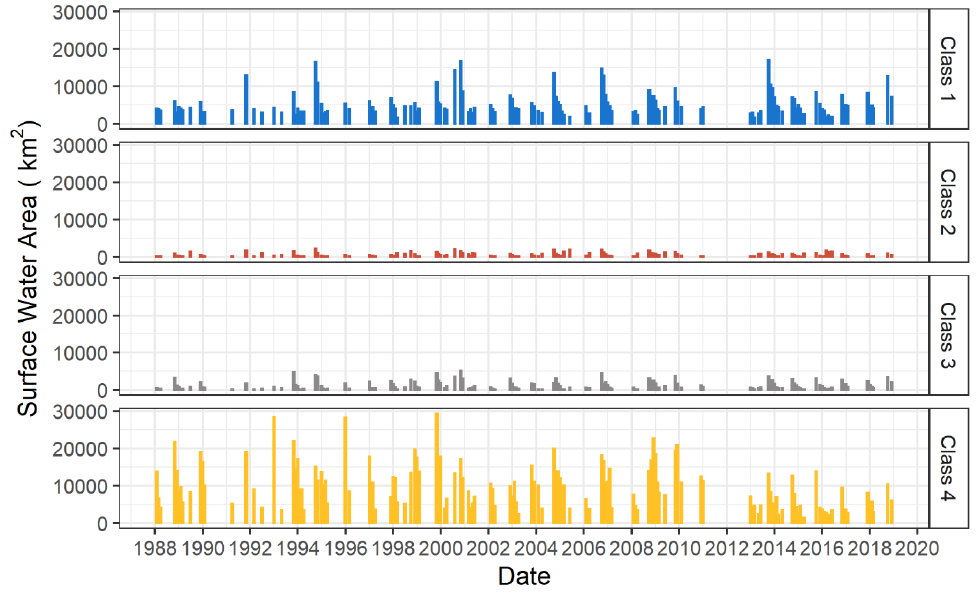
Figure 4. Surface water area by DSWE water class for Cambodia, plotted for each month that had >80% Landsat coverage and <20% clouds. DSWE water classes are as follows: Class 1—high confidence water, class 2—moderate confidence water, class 3—partial or vegetated class, and class 4—water or wetland—low confidence.